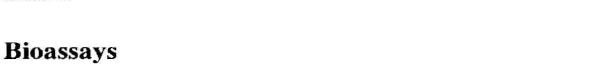
with IC so values of 0.43 and 0.26 f.lM. All of 10 these compounds were N -methyl derivatives, and almost all were more active than the cor 10 responding N -unsubstituted analogues except 19h, which was slightly more active than 19c against rat liver and T. gondii DHFR but not P. carinii DHFR. Although increased DHFR bind ing was reported recently for the NlO -methyl deri vatives of 2,4-diamino-6-arylaminomethyl-5,6,7,8- tetrahydroquinazolines (10), this has not been stu died previously with 2,4-diamino-6-arylam